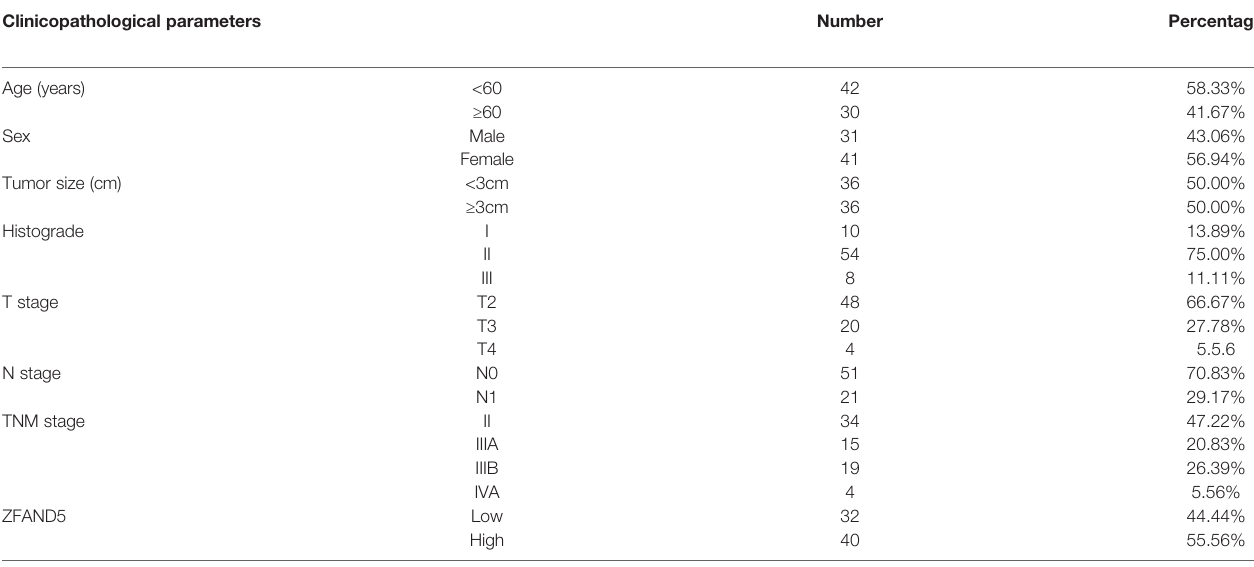
TABLE 1 | The basic infromation of the pCCA